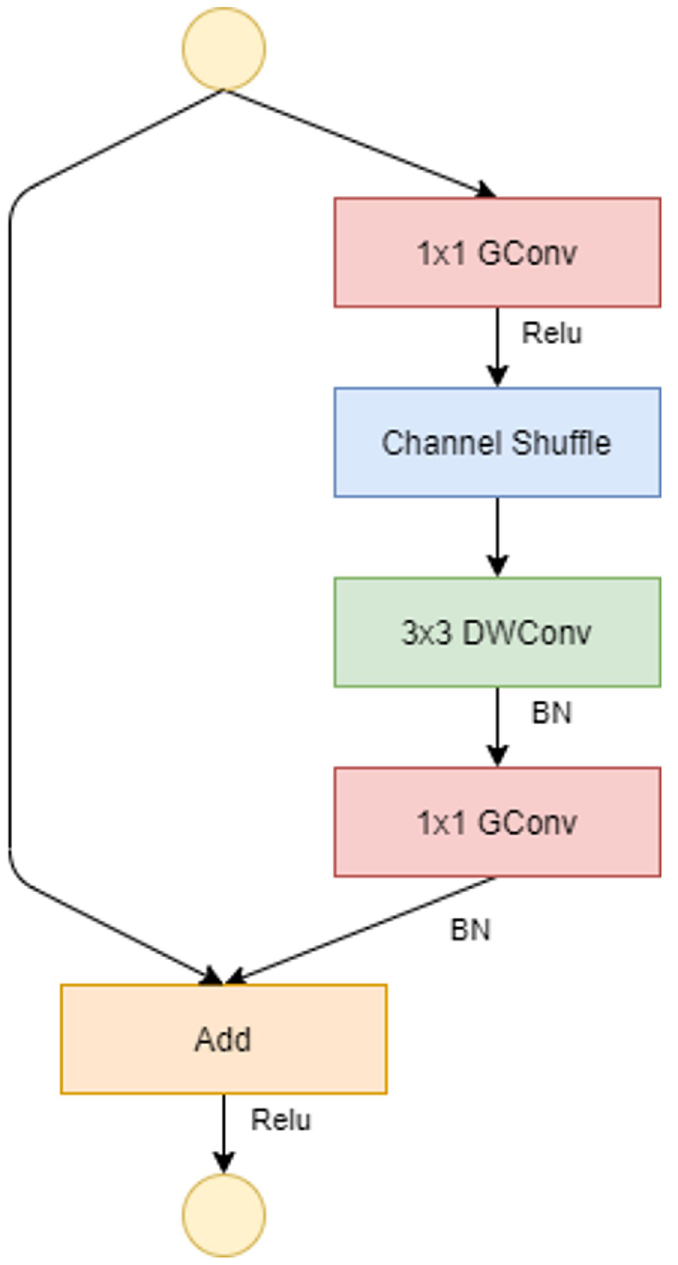
Fig 2. Methodology to classify QRS